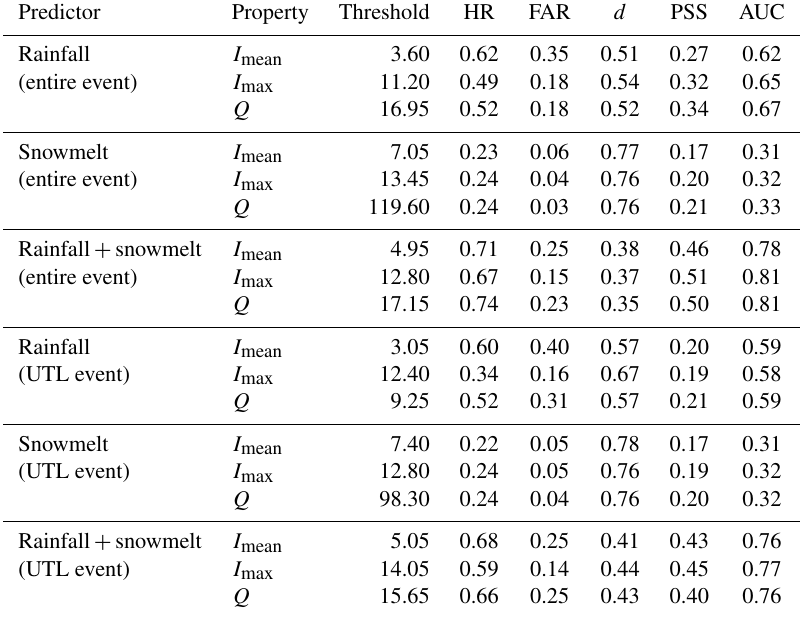
Table 1. Calibrated thresholds of mean intensity I mean (mmd − 1 ), maximum intensity I max (mmd − 1 ), and accumulated amount Q (mm) for entire events and UTL events of rainfall, snowmelt, and the sum of rainfall and snowmelt (rainfall + snowmelt), as well as corresponding performance